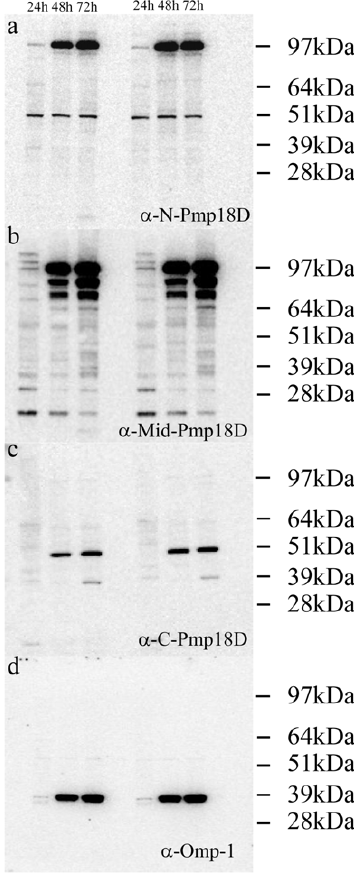
Figure 1. Western blot demonstrating an increase in Pmp18D expression and proteolytic cleavage over the 72 h C.abortus developmental cycle using: a) anti-N-Pmp18D, b) anti-Mid- Pmp18D, c) anti-C-Pmp18D pAbs and d) anti-Omp-1 mAb 4/11.